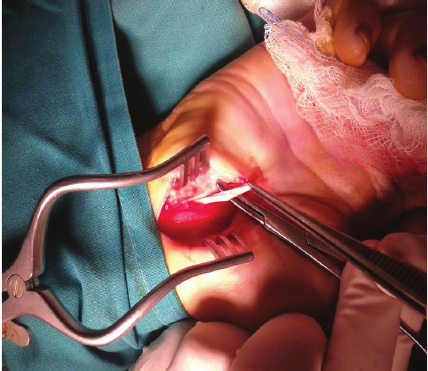
Figure 3: Removal of palmaris profundus after its traction during the